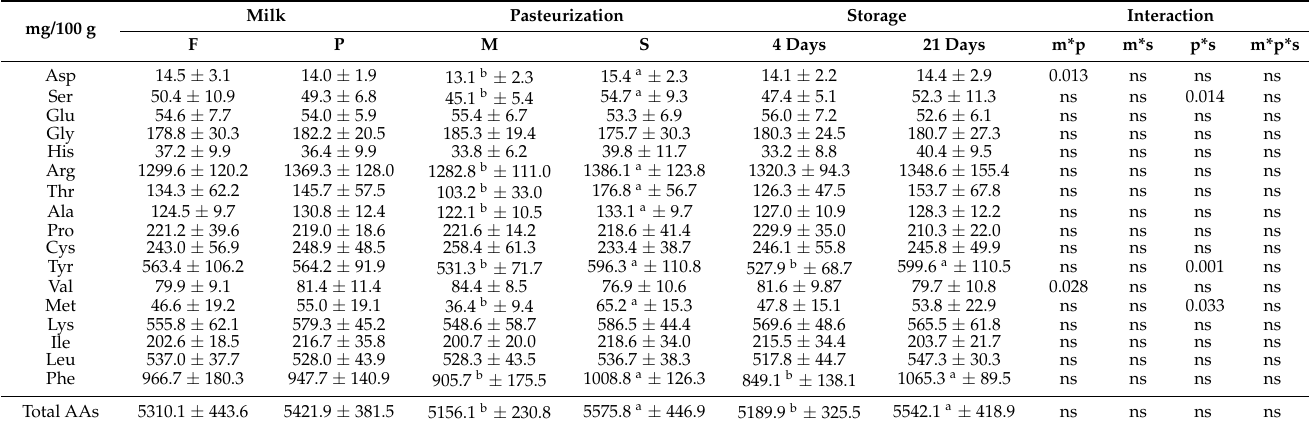
Table 4. Estimated least square means of amino acid (AA) content after in vitro digestion of cheese considering three fixed factors with two levels each: type of milk (F and P), pasteurization level (M and S), and cheese storage (4 days and 21 days) as well as their interactions. F: fresh milk; P: pre-treated milk; M: minimal pasteurization; S: strong